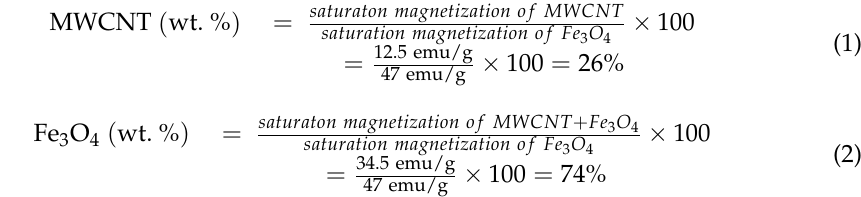
Figure 4. Magnetic results of the synthesis MWCNT + Fe 3 O 4 hybrid nanoparticles.